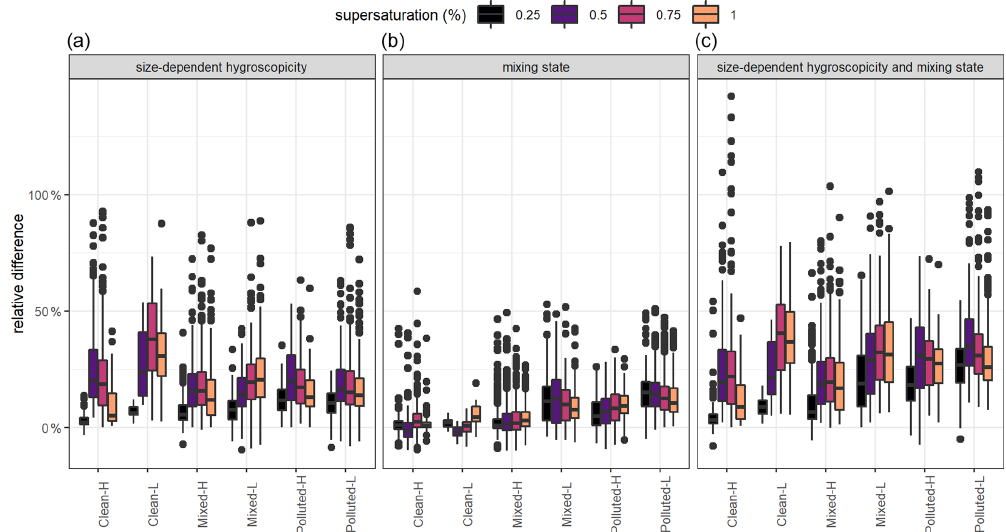
Figure 6. The relative difference induced by ignoring size-dependent hygroscopicity (a) , simplification of the aerosol as complete internal mixing state (b) , total error in the first two assumptions (c) . The lines represent medians, the boxes represent 25th to 75th quantiles, the whiskers represent the 1.5 interquartile, and the points represent